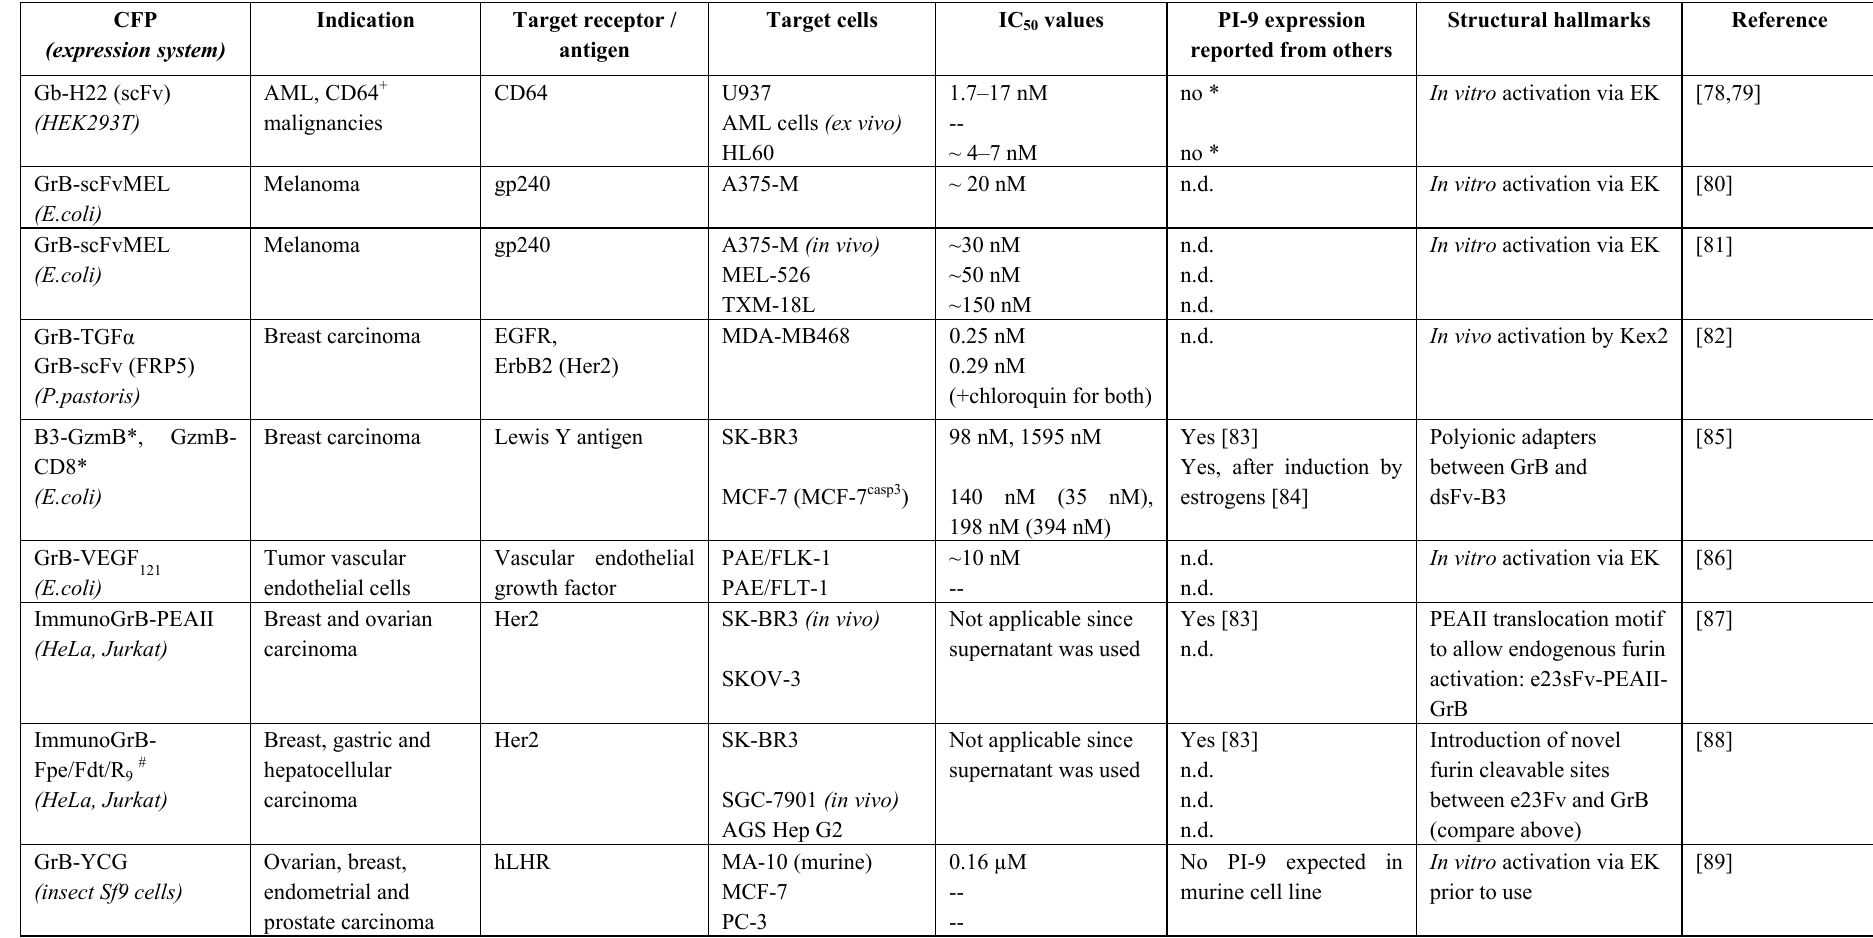
Table 1. Overview of different granzyme B-based cytolytic fusion proteins (CFPs) published so